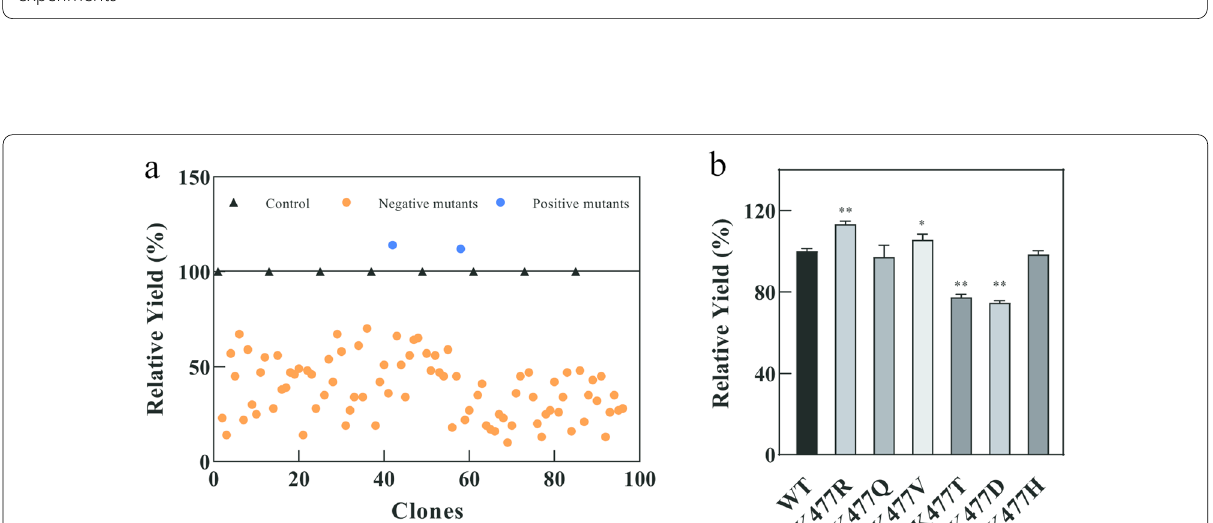
Fig. 2 Directed evolution of CadA. a High-throughput screening of error-prone PCR mutation libraries. b Site-directed mutagenesis of K477. The error bars represent standard deviations calculated from triplicate experiments, and statistical significance of the different relative cadaverine yield in comparison with the wild type was evaluated using Student’s t test (*, P < 0.05, **, P <